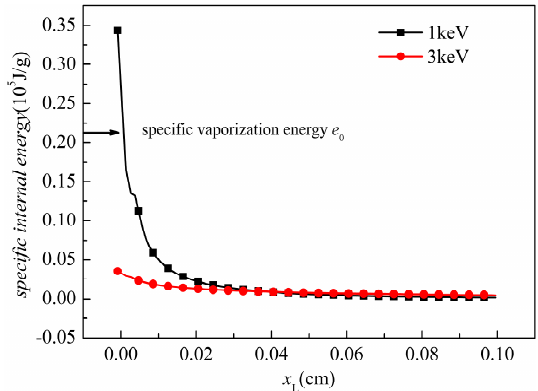
Figure 11. Initial energy distribution after the radiation.